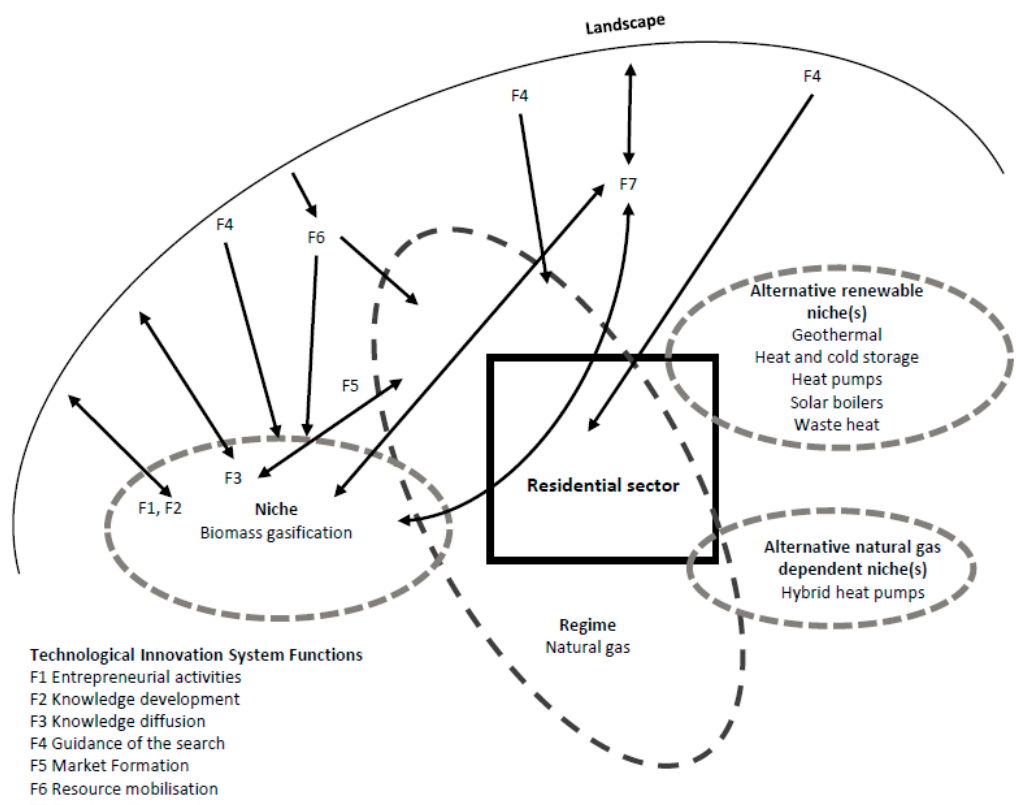
Figure 1. Overview of the TIS functions for biomass gasification, including alternative niches for residential heat supply, the natural gas regime, the residential sector and the landscape level. The arrows indicate the dynamics between different levels and the TIS functions, single arrows indicate unilateral pressures, whereas double arrows indicate bilateral dynamics combined with the system functions from TIS. The residential sector is presented as a black box to emphasise its position as a captive customer within the natural gas regime. Figure 1 is based on Reference [30].